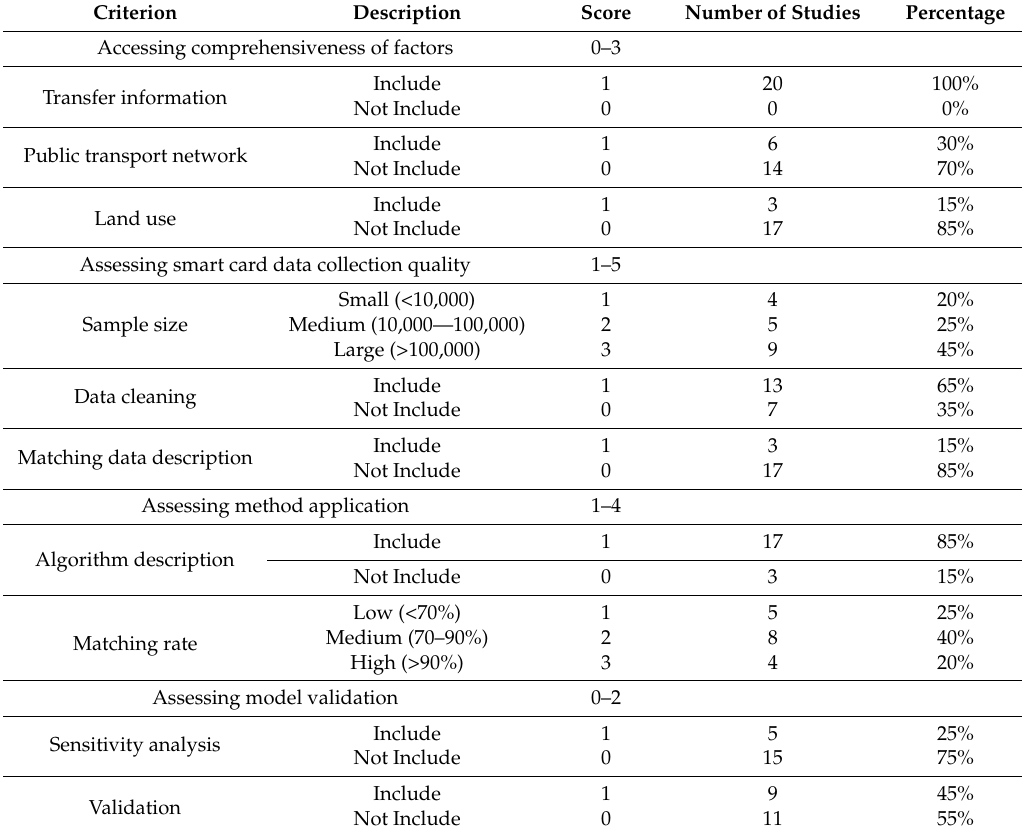
Table 11. Quality distribution of reviewed